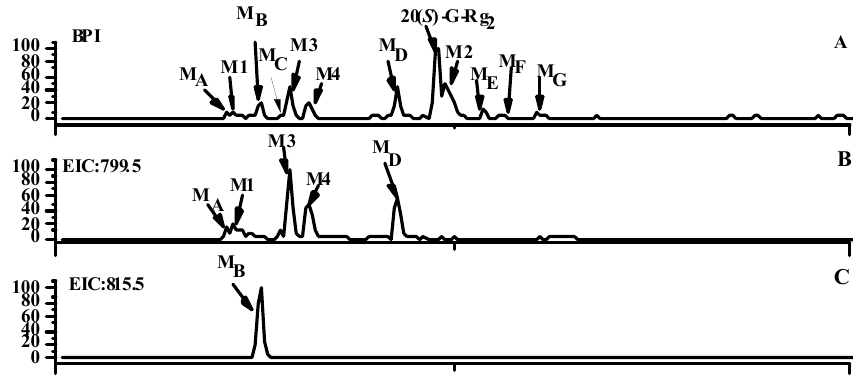
Figure 1. Con t. Figure 1.